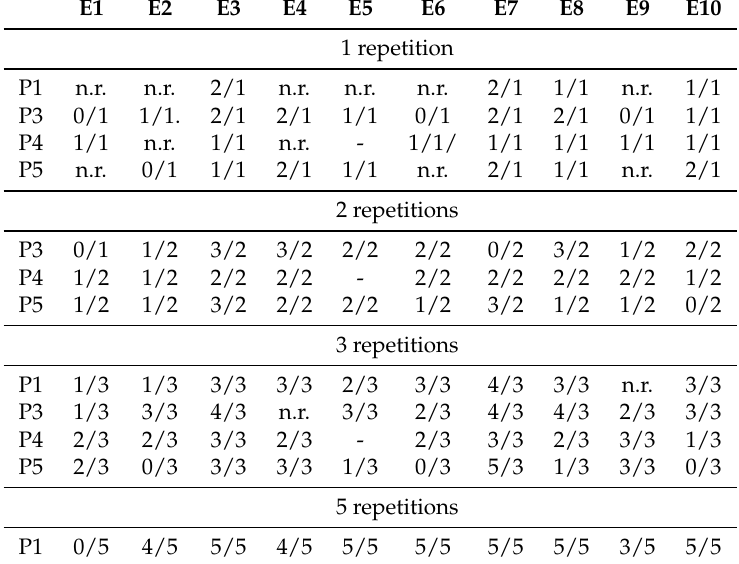
Table 9. Predicted number of repetitions for 1, 2, 3, and 5 performed repetitions. n.r.: Not